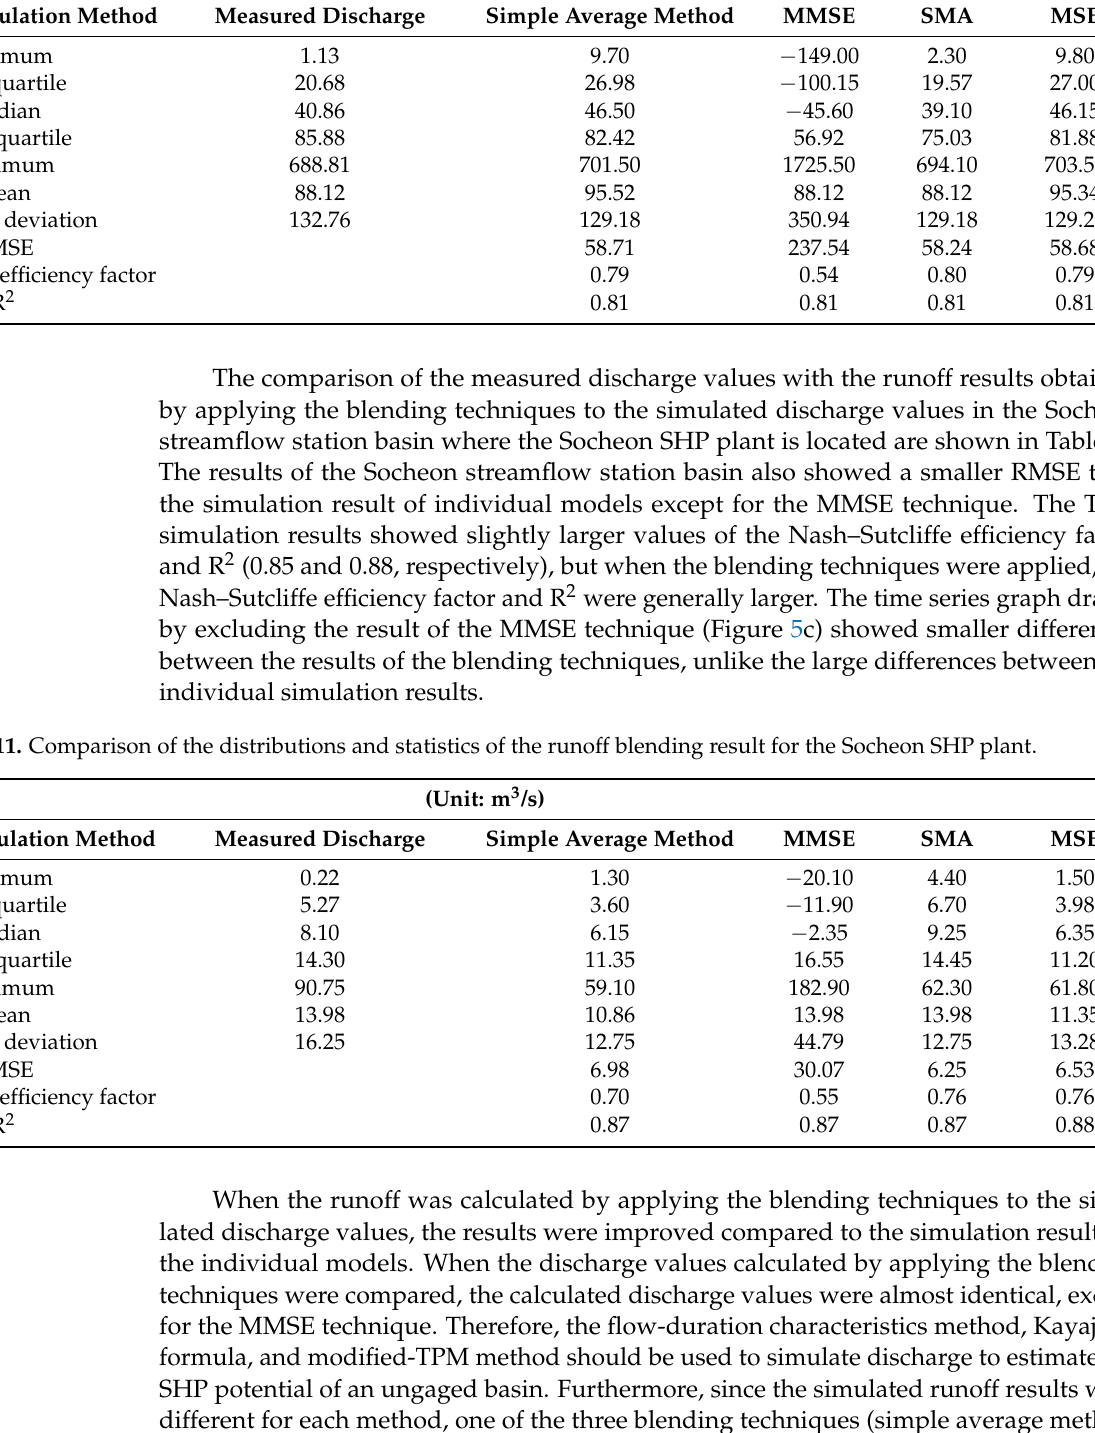
Table 10. Comparison of the distributions and statistics of the runoff blending result for the Hanseok SHP plant. (Unit: m 3 /s)